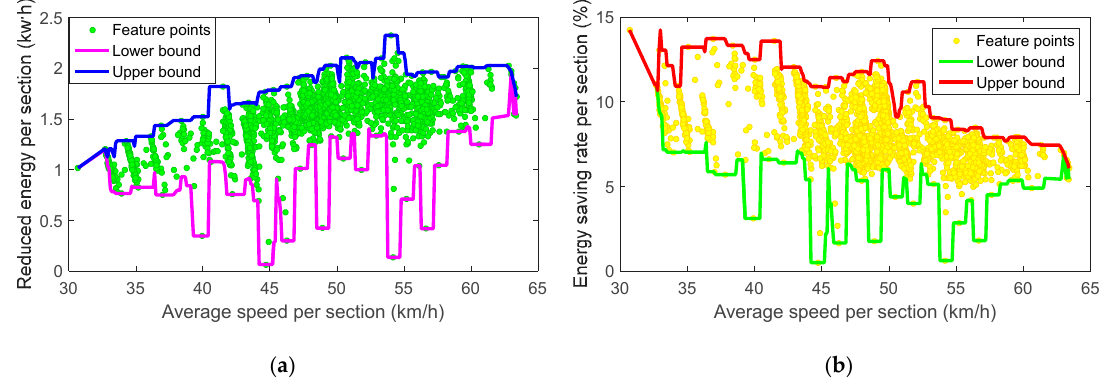
Figure 12. Boundaries of ASS-REN-PLF and ASS-RER-PLF profiles (weekend, SH-TQ, N p = 414). ( a ) ASS-REN-PLF profile result; ( b ) ASS-RER-PLF profile result.